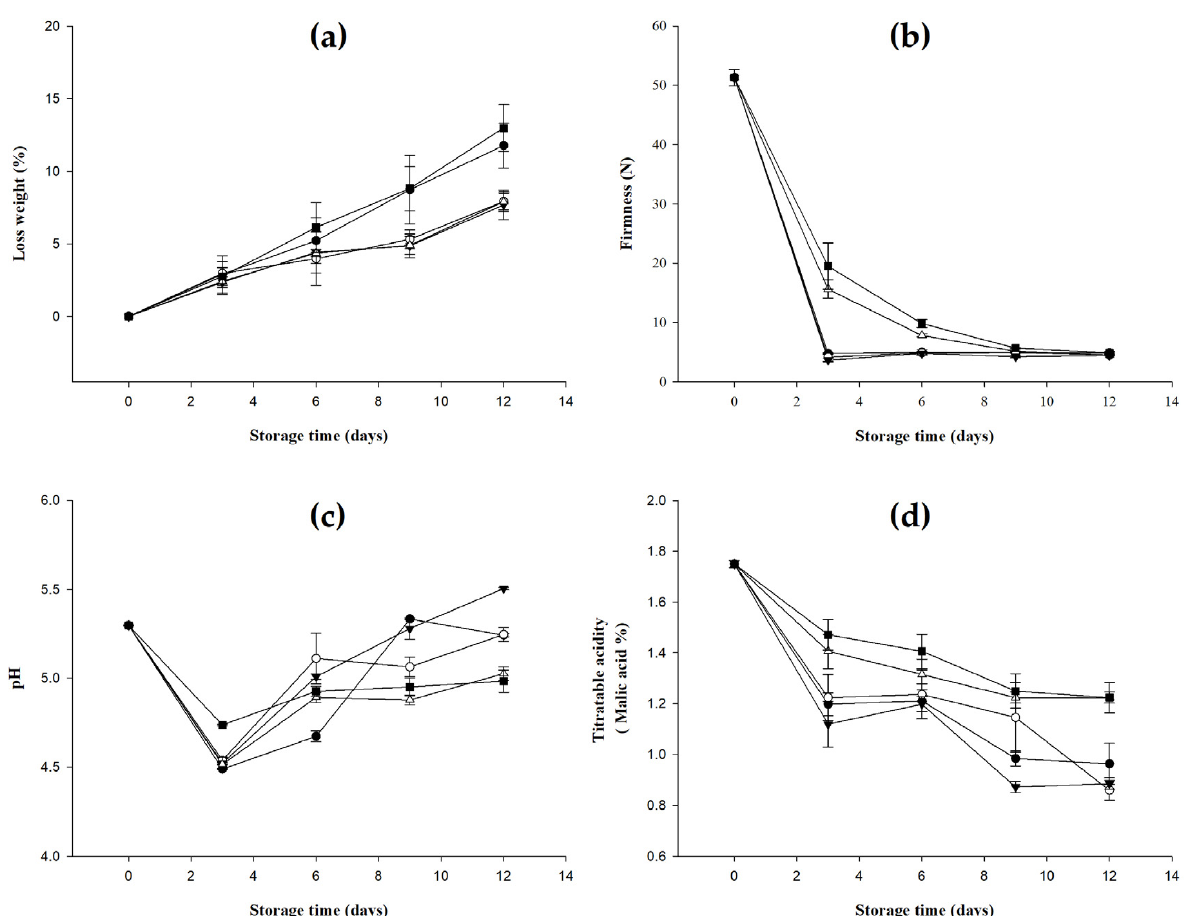
Figure 2. Effect on ( a ) weight loss, ( b ) firmness, ( c ) pH, and ( d ) titratable acidity (triplicate mean ± SD) of bananas coated with different concentrations of D-limonene nanoemulsion edible film and stored at 13 ± 1 °C from 0 to 12 days. (